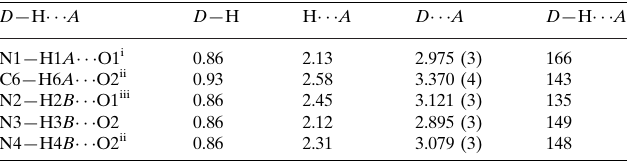
Hydrogen-bond geometry (A˚ , (cid:3)